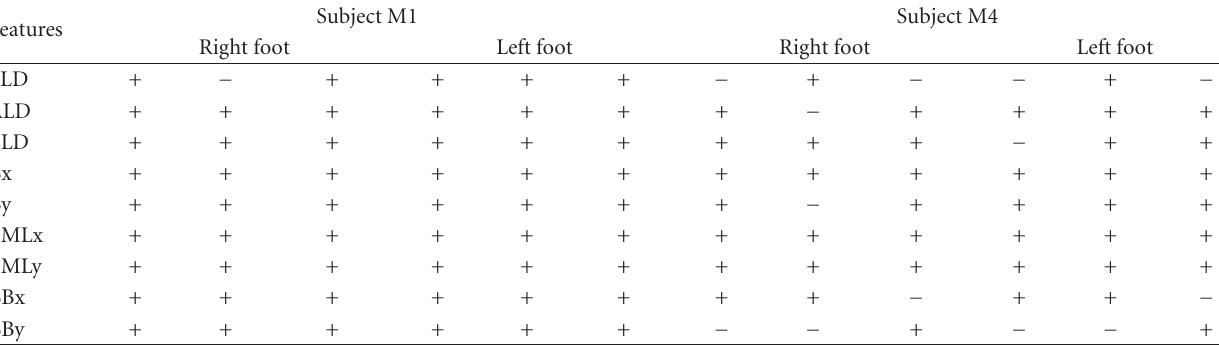
Table 2: Student’s t -test analysis of features in female subjects F1 and F4 over 3 sessions with the 3D guide ( P > . 000125 → “+,” P < . 000125 → “ − ”).